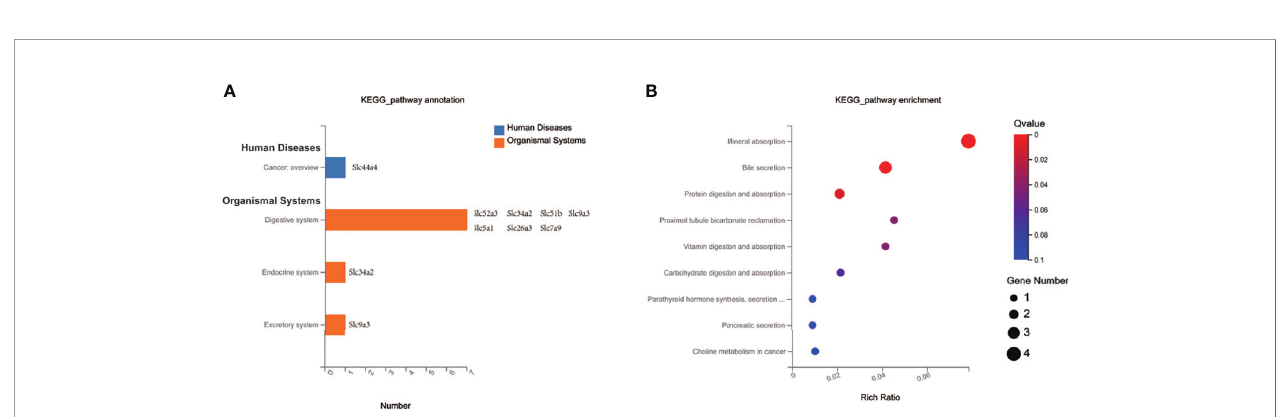
FIGURE 6 | KEGG pathway enrichment analysis of MET-responsive Slc genes in liver. (A) KEGG pathway annotation and classi fi cation of common Slc transporters DEGs in liver. (B) Scatterplot of KEGG enrichment pathways associated with metabolic balance of common Slc transporters DEGs in